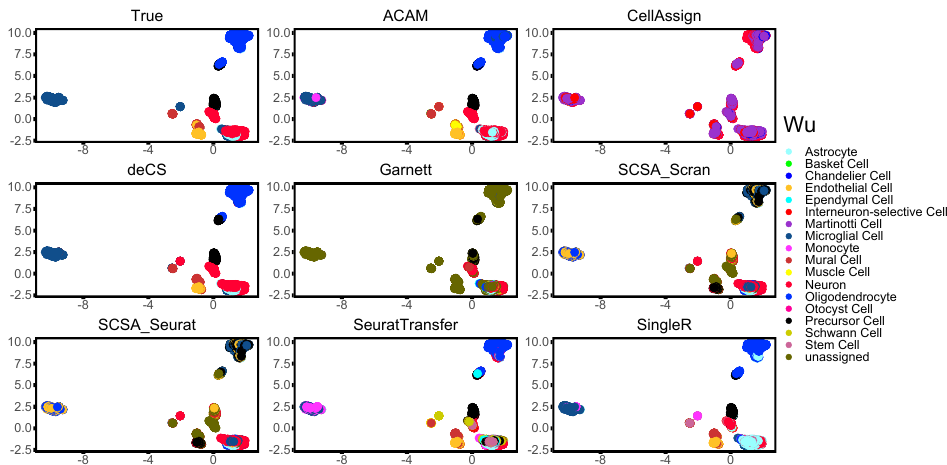
Figure 6. Two-dimensional visualization of the annotation results for dataset Wu using